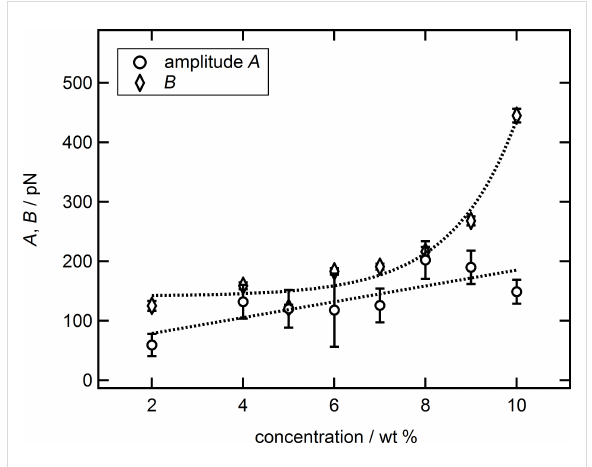
Figure 10: Amplitude A (circles) as well as parameter B (diamonds) in pN as a function of the suspension concentration in wt % together with trends (dotted lines). The large increase in B at higher concentrations matches with the observed deviation between experimental data and the common fit